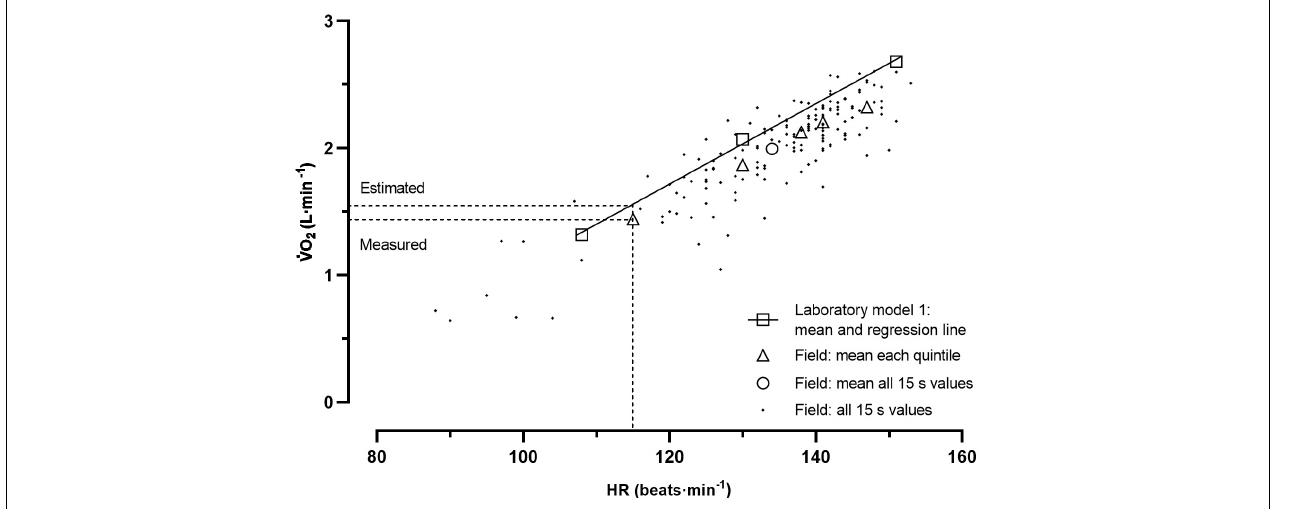
FIGURE 1 | An individual example of the heart rate (HR) and oxygen uptake (˙VO 2 ) measurements during the cycle commuting in field as well as the estimated ˙VO 2 based on the HR-˙VO 2 relationship from the submaximal ergometer cycling (model 1) in the